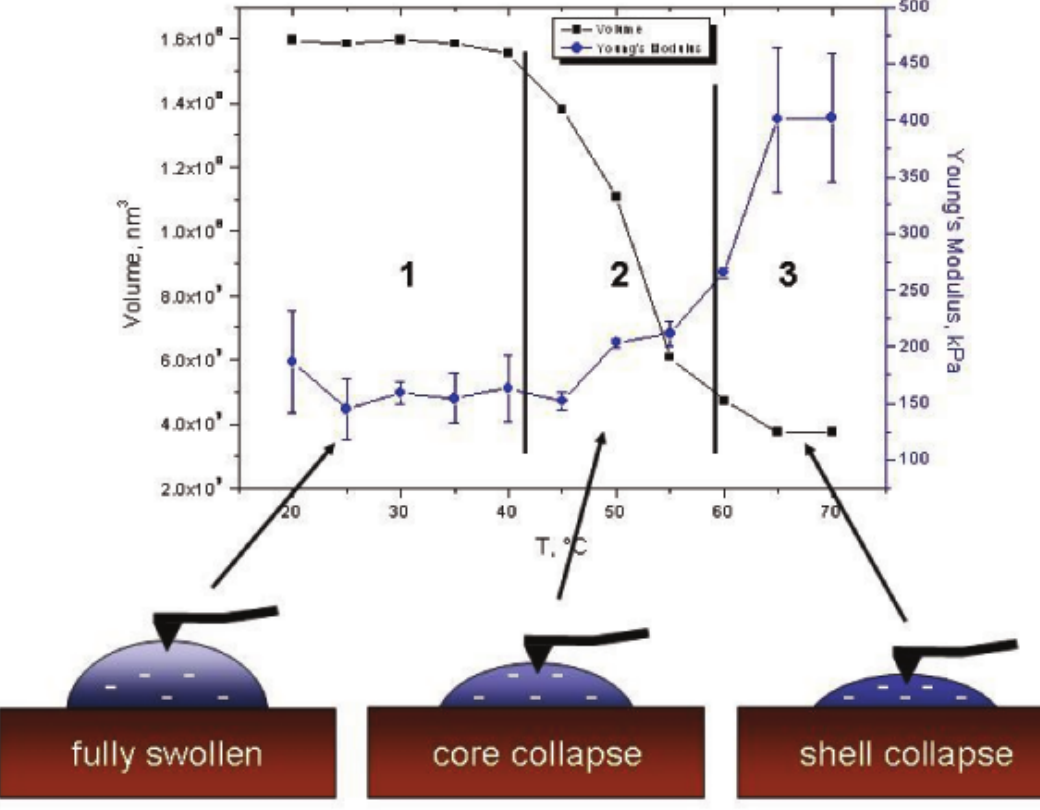
Figure 11. Shrinking process of the microgel containing 20% AAc. The black curve represents the particle volume and the blue line corresponds to the Young’s modulus: (1) swollen state: the particle exhibits its largest size and lowest Young’s modulus, (2) core shrinking process: the size decreases slightly, while the elasticity stays more or less constant, (3) shell collapse: a further reduction in size and an enhancement in stiffness take